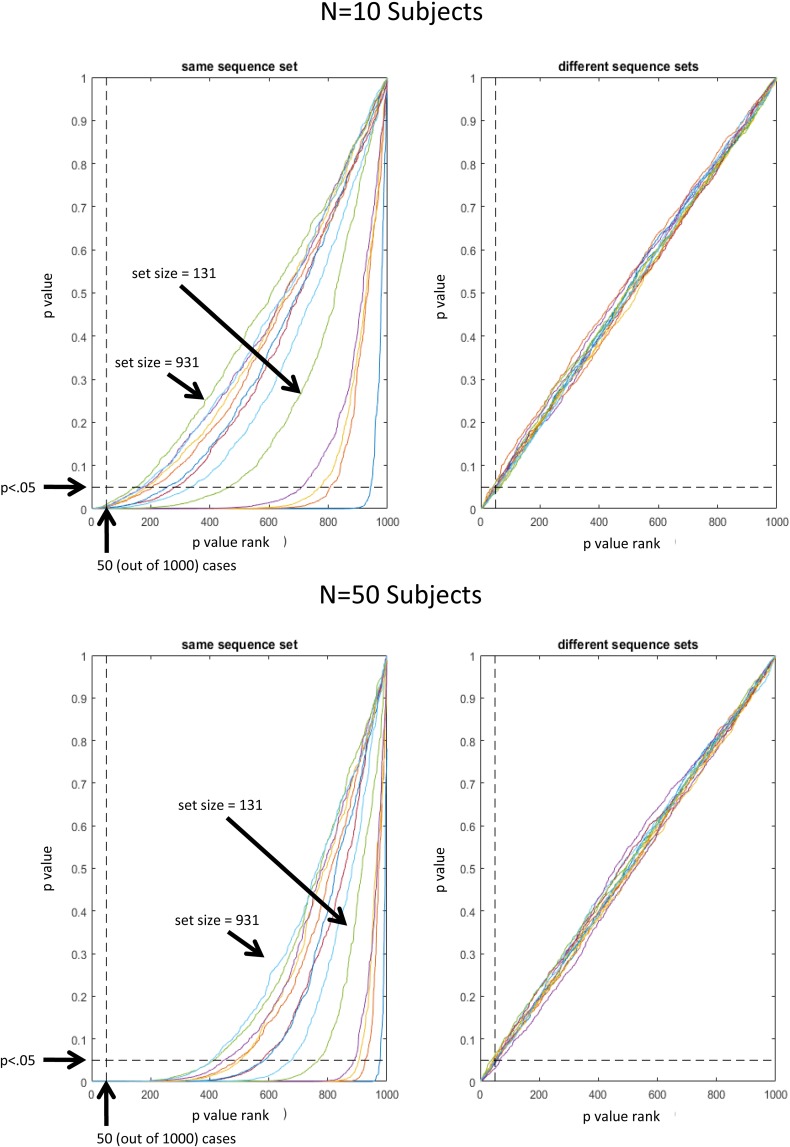
Plot of p(t)-values as a function of p-value rank. For unbiased results, all p-values associated with rank 50 and greater, are expected greater than 0.05. Different lines represent different sequence set sizes (1, 11, 21, 31, and 131, 231, 331, 431, 531, 631, 731, 831, 931).